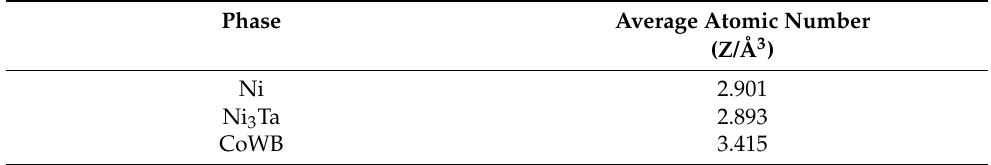
Table 3. Average atomic number per unit volume of the phases precipitate in the composites.